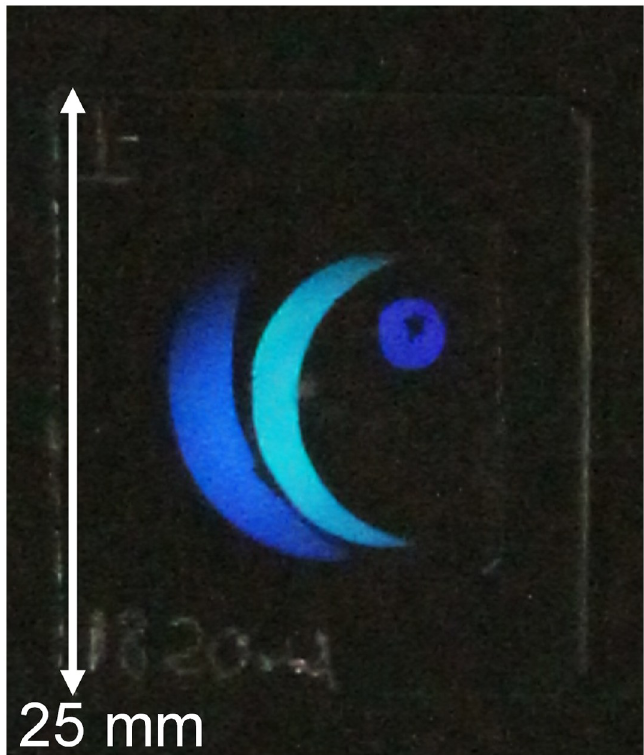
Fig 3. Photograph of the reconstructed image hologram consisting of SiO 2 on soda-lime silicate glass.